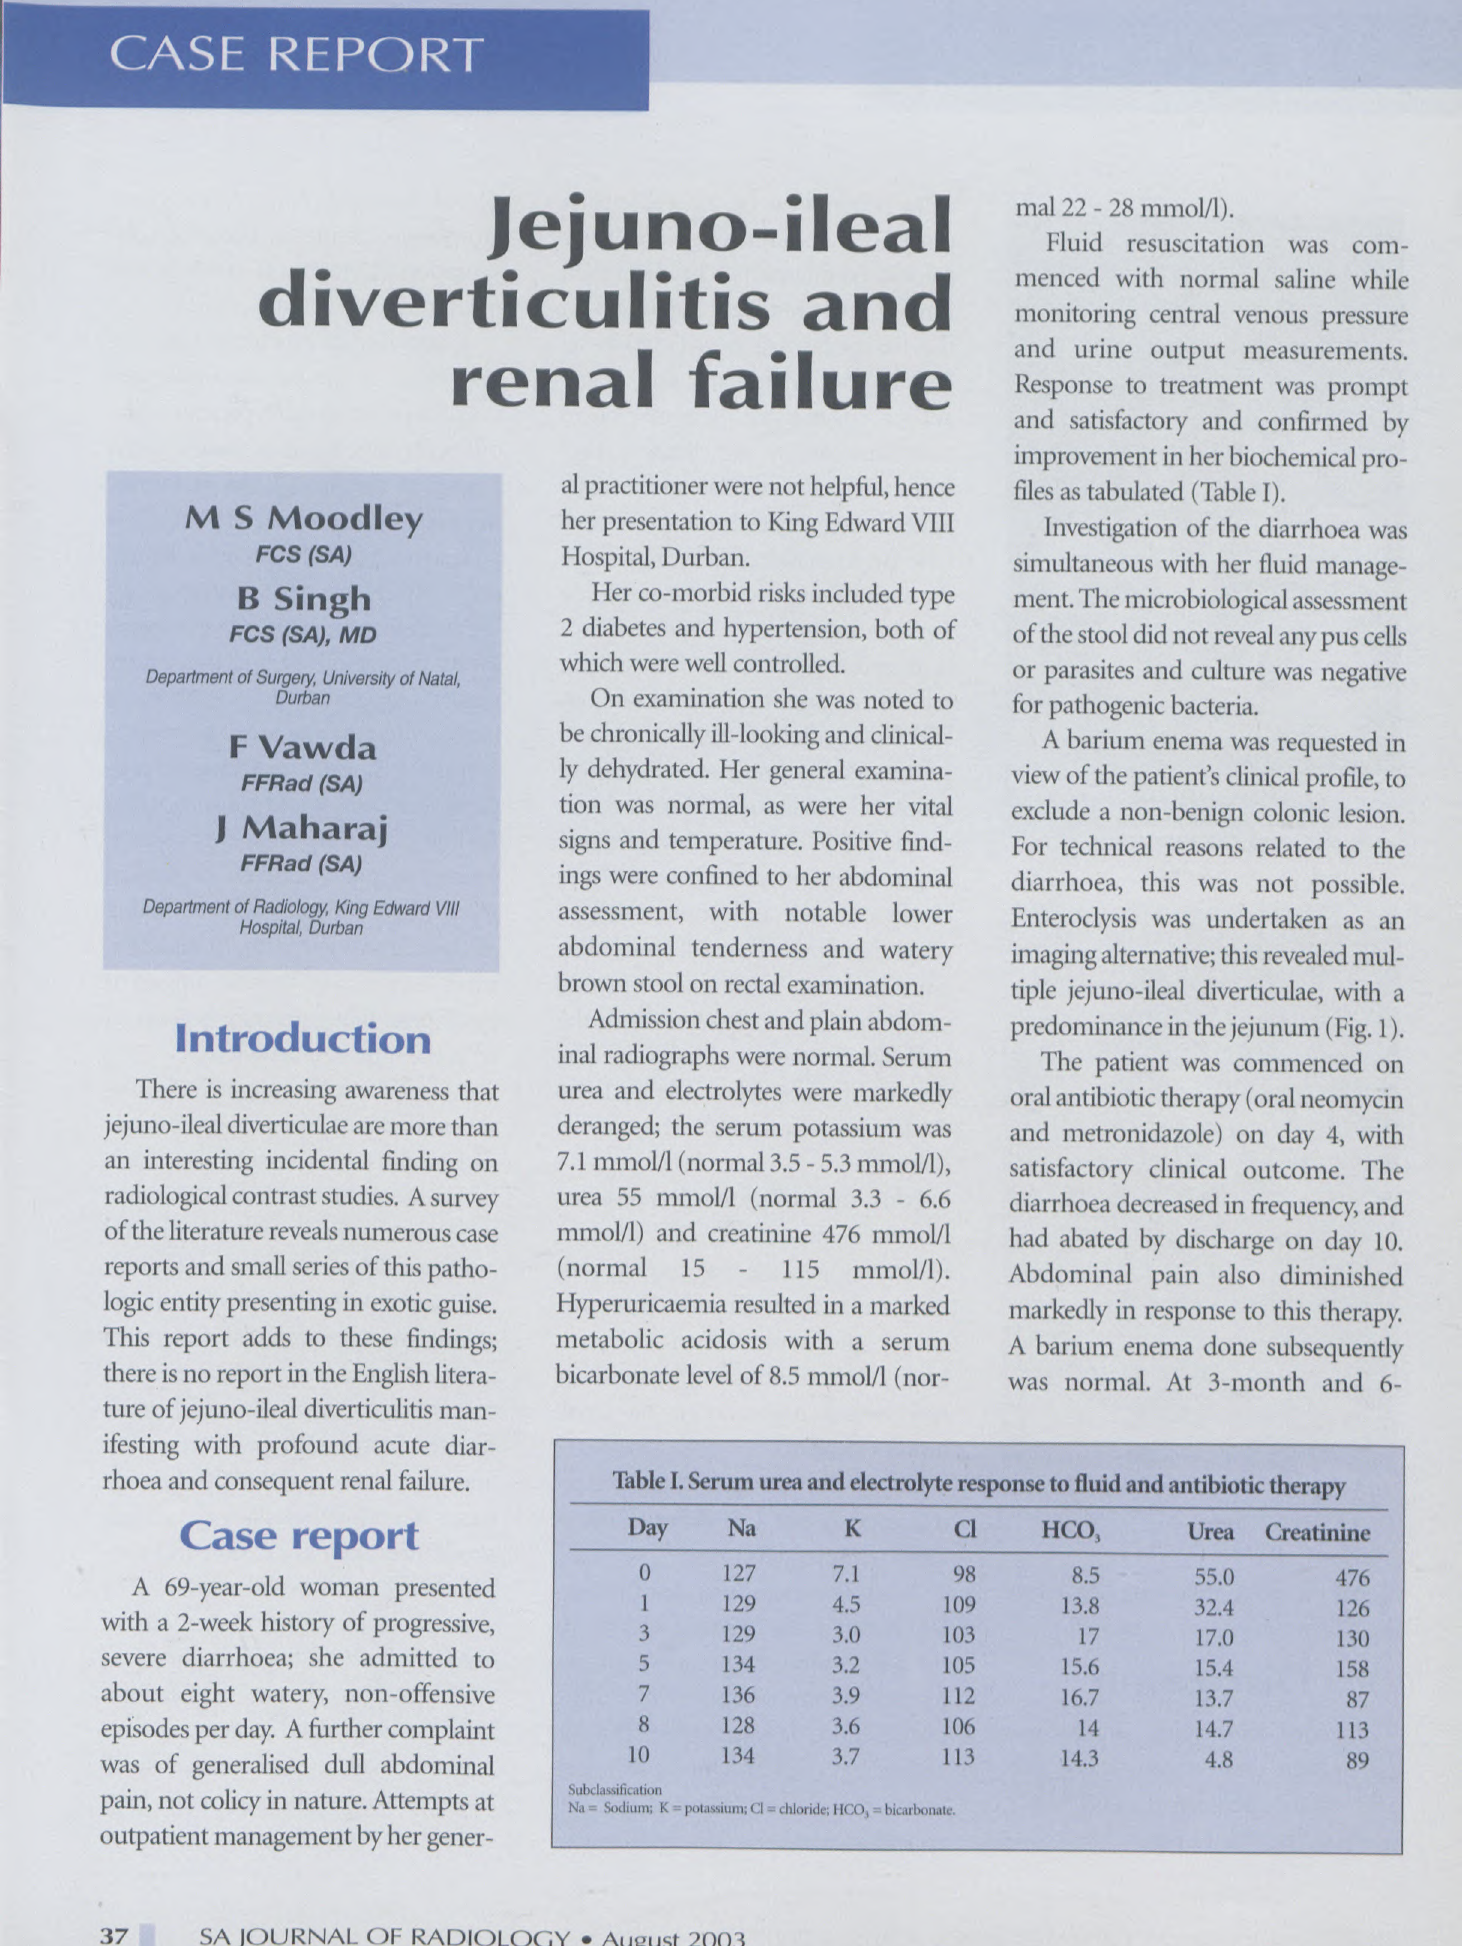
Table I. Serum urea and electrolyte response to fluid and antibiotic